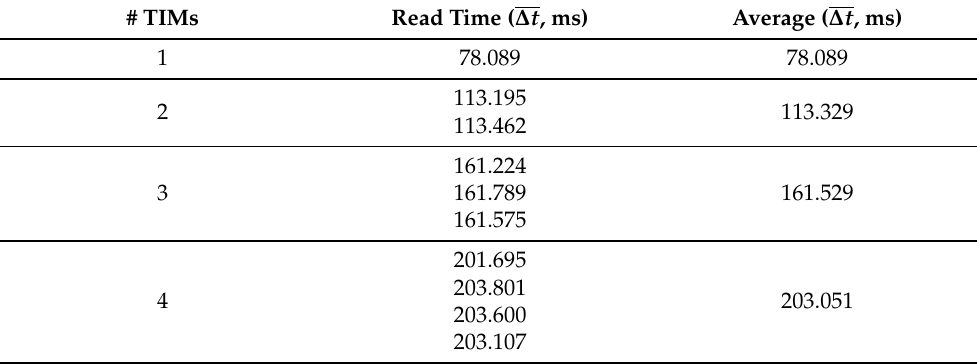
Table 3. Read Sensor Tests—Total Times, direct access to TS.